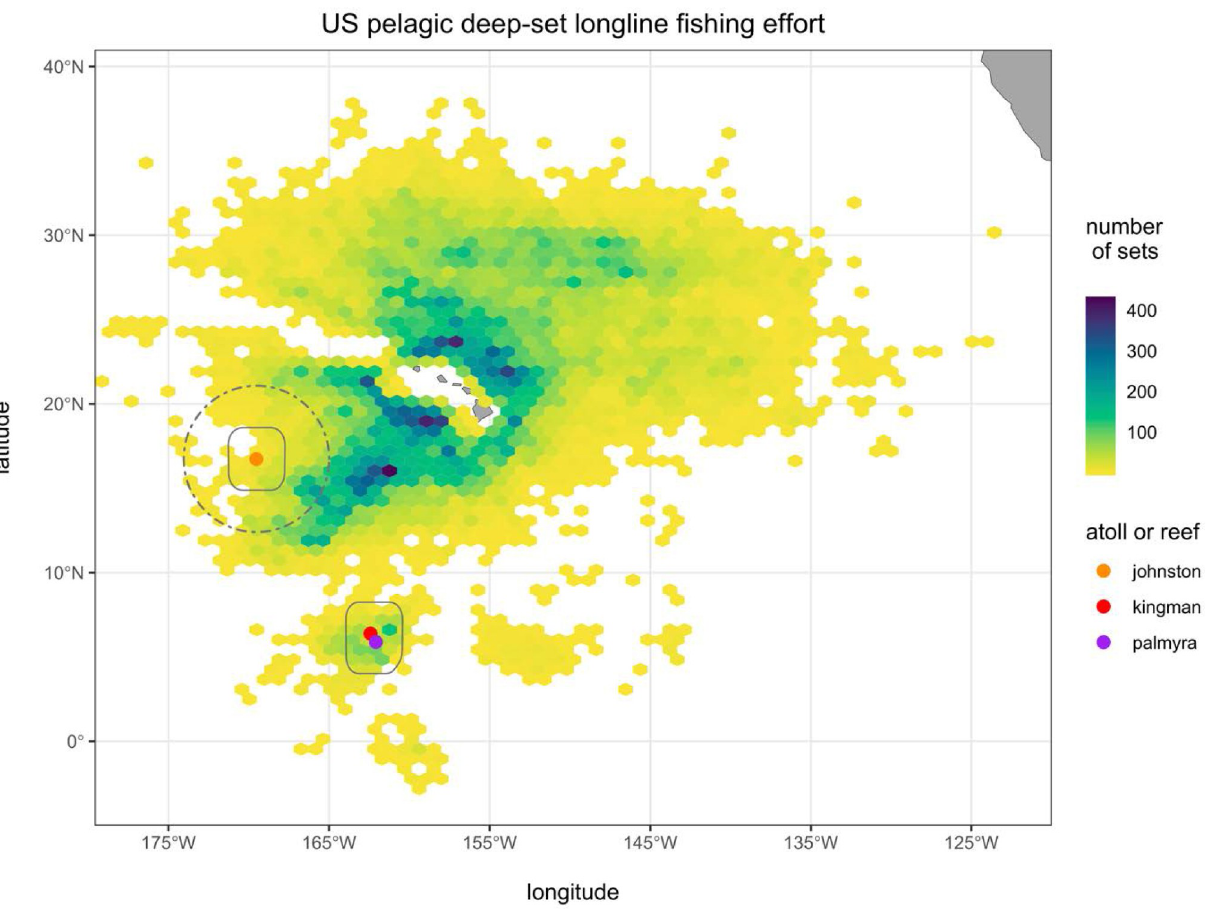
Fig 5. Spatial density trend in Hawaii tuna pelagic longline fishing effort (1994–2018) shown using hexagon binning with � 50 sets per bin. The 110 nm seaward margin (treatment zone boundary) around Kingman/Palmyra and Johnston shown by a solid-line polygon. The 260 nm seaward margin (treatment zone boundary) around Johnston shown by a dashed-line